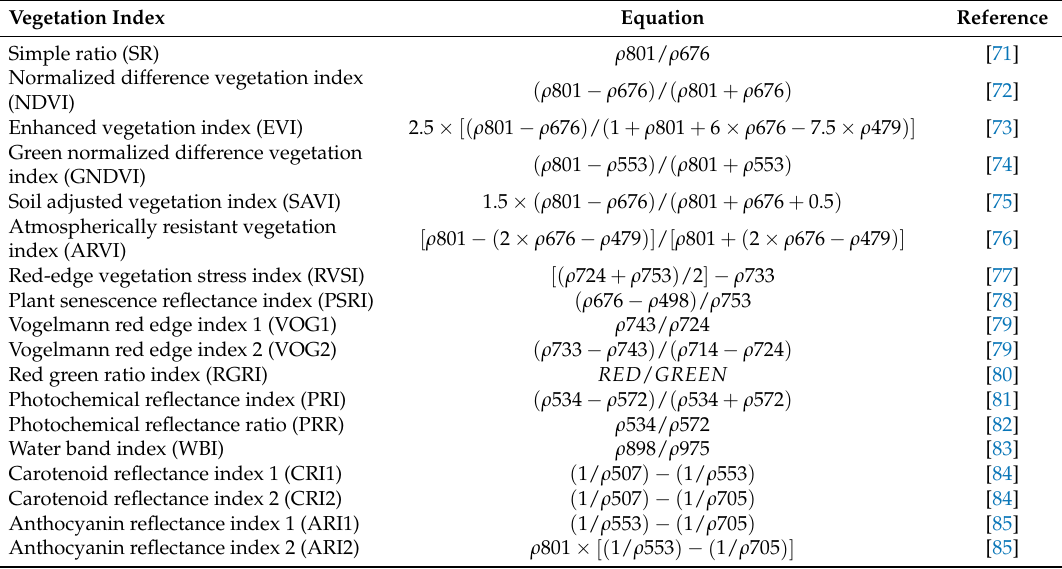
Table 4. A summary of the vegetation indices with respective equations and references. Wavelengths chosen were the closest AISA wavelengths to the equations in the cited